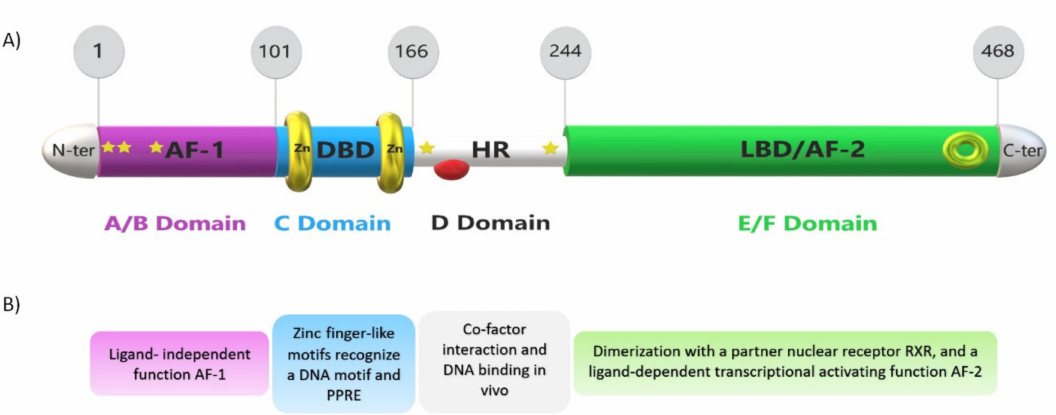
Figure 4. Schematic view of PPAR α structure and domain function, with phosphorylation and cofactor binding sites. From the left N-terminus to the right C-terminus of the PPAR α protein, ( A ) domain structure of the PPAR α protein with the ligand-independent activation function-1 (AF-1) domain or A/B domain shown in purple, the DNA-binding domain (DBD) or C domain shown in blue with two zinc finger-like motifs, the hinge region (HR) or D domain shown in white, and the ligand-binding domain (LBD) or E domain together with the activation function 2 (AF-2) or F domain shown in green. Phosphorylation sites are labeled with yellow stars (6, 12, 21, 179, 230) amino acids, the corepressor site is marked with a red half-sphere, and the coactivator binding site is shown with a green ring. The panels on top show the number of amino acid residues. ( B ) Structural function of A/B, C, D, and E/F domains,